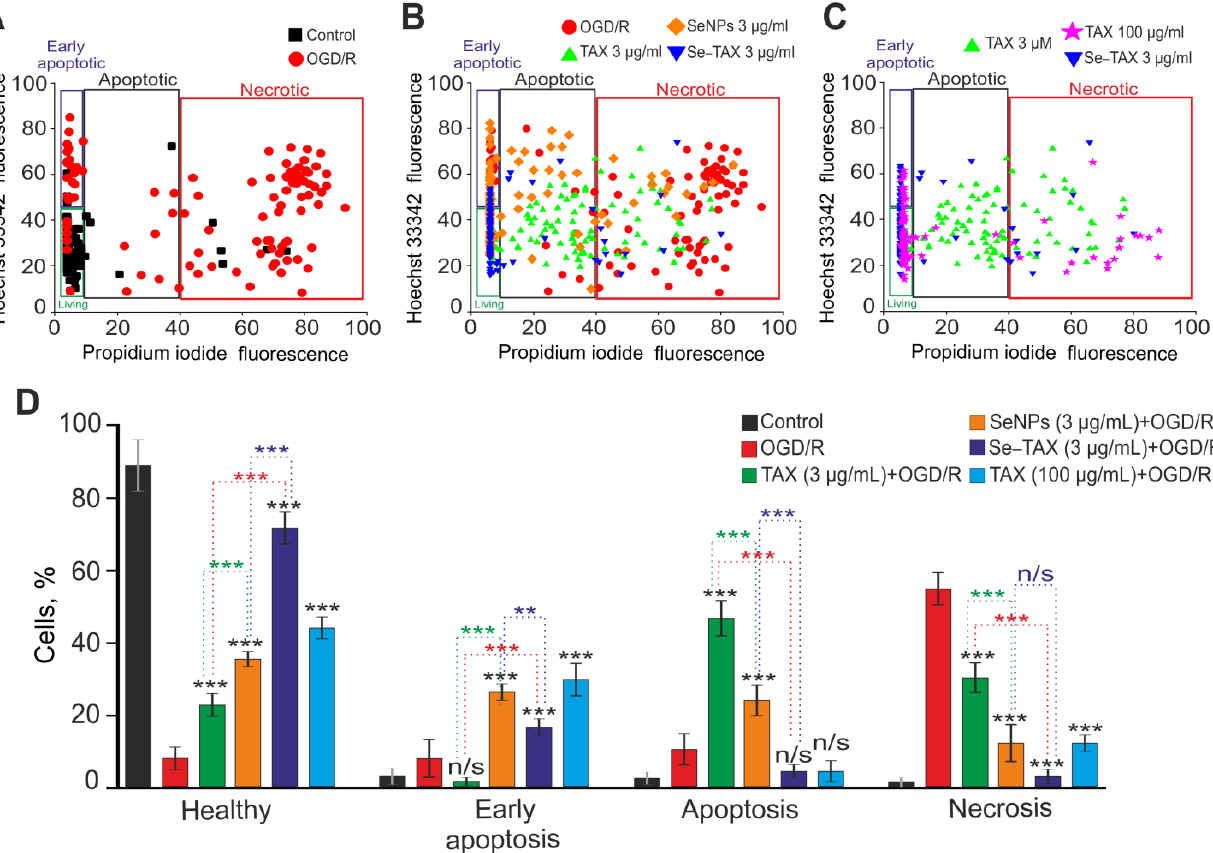
Figure 7. The effects of 24 h cell incubation with TAX (3 or 100 μg/mL), SeNPs (3 μg/mL) , or Se – TAX (3 µg/mL) on the survival of cerebral cortical cells after 2 h OGD and 24 h reoxygenation (OGD/R). ( A – C ) Cytograms demonstrating the viability of cortical primary cultured cells in control (without OGD/R) and after OGD/R (A), after OGD/R with TAX (3 μg/mL), SeNPs (3 μg/mL) , or Se – TAX (3 µg/mL) ( B ) and after OGD/R with TAX (3 or 100 μg/mL) and Se – TAX (3 µg/mL) ( C ). X-axis — the intensity of PI fluorescence; Y-axis — the intensity of Hoechst 33342 fluorescence. Cells were stained with the probes 24 h after the OGD/R. ( D ) Effect of 3 or 100 μg/mL TAX, 3 μg/mL SeNPs, or Se – TAX on the induction of necrosis and apoptosis 24 h after OGD/R. N cell cultures = 5; n cover slips with cells for each sample = 5. For panel D , results are presented as mean ± SEM. Black asterisks indicate the differences between the experimental groups comparable to the OGD group. Differences between experimental groups are marked with asterisks of different colors. n/s — data not significant ( p > 0.05), *** p < 0.001 and ** p < 0.01. Cell images are presented in Supplementary Figure S1. Survival of brain cells under conditions of ischemia/reoxygenation depends on the redox status of the cells. Using PCR analysis, it was found that TAX reduced the basic expression of Nox1 and increased the level of Sod1, Mao-A, and Cat (Figure 8A, TAX), indicating an increase in the antioxidant status of cells. SeNPs are less effective in regu- lating the antioxidant status o f cells. Preincubation with 3 μg/mL SeNPs resulted in an increase in the baseline expression of Mao-A and Cat with a decrease in the level of Nos1 (Figure 8A, SeNPs). Incubation of cells with the Se – TAX nanocomplex resulted in a striking change of the basic expression of the genes that regulate the redox status. Two hours after incubation of cells with Se – TAX, the expression of most of the genes encoding ROS generating the proteins Nox1, Moa-A, Moa-B, and Nos1 was suppressed. This oc- curred simultaneously with an increased expression of genes encoding the ROS-consuming proteins Sod1, Sod2, and Cat (Figure 8A, Se – TAX).